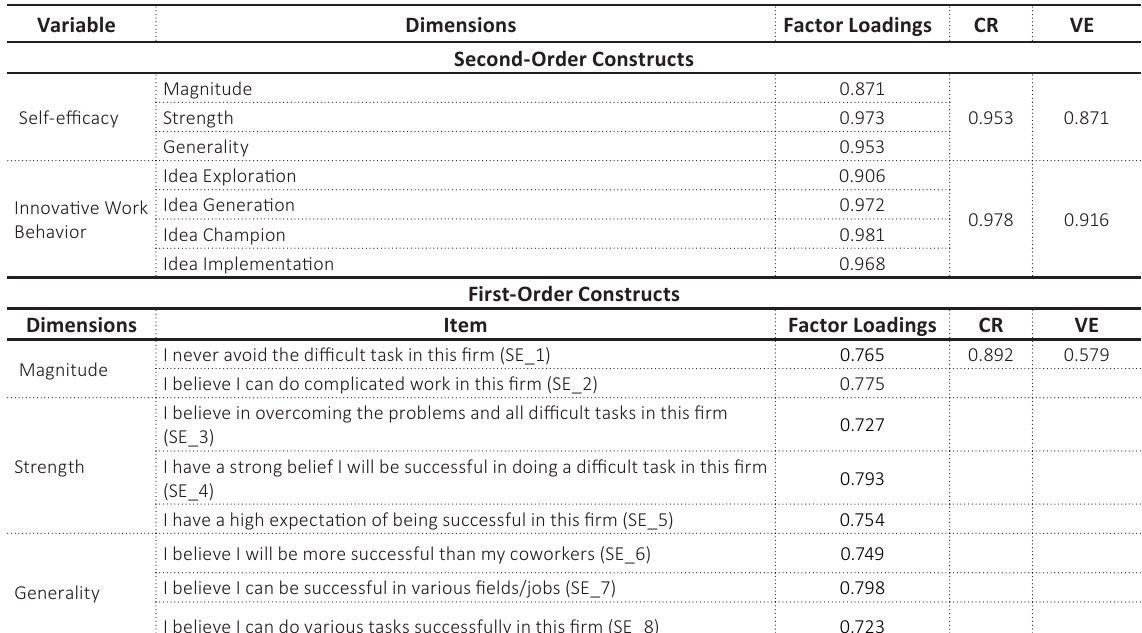
Table 2. Multidimensional measurement